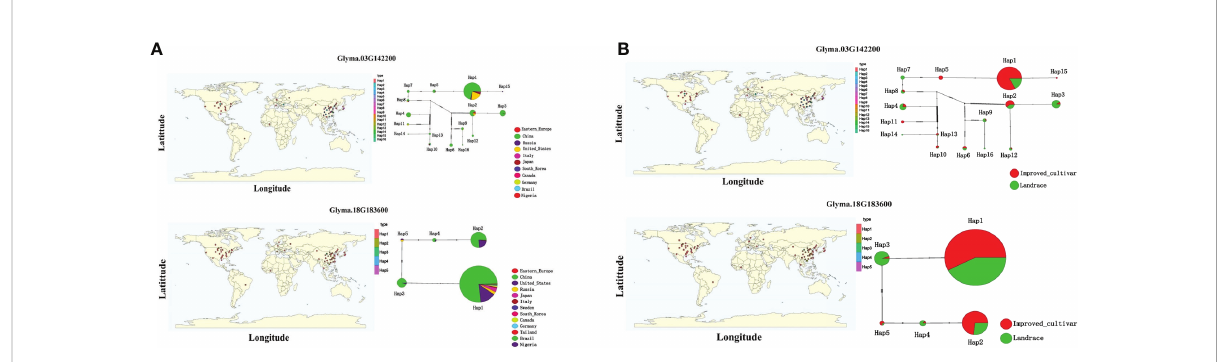
FIGURE 10 Haplotype analysis of candidate genes (A) distribution of geographical origin (B) distribution of cultivar